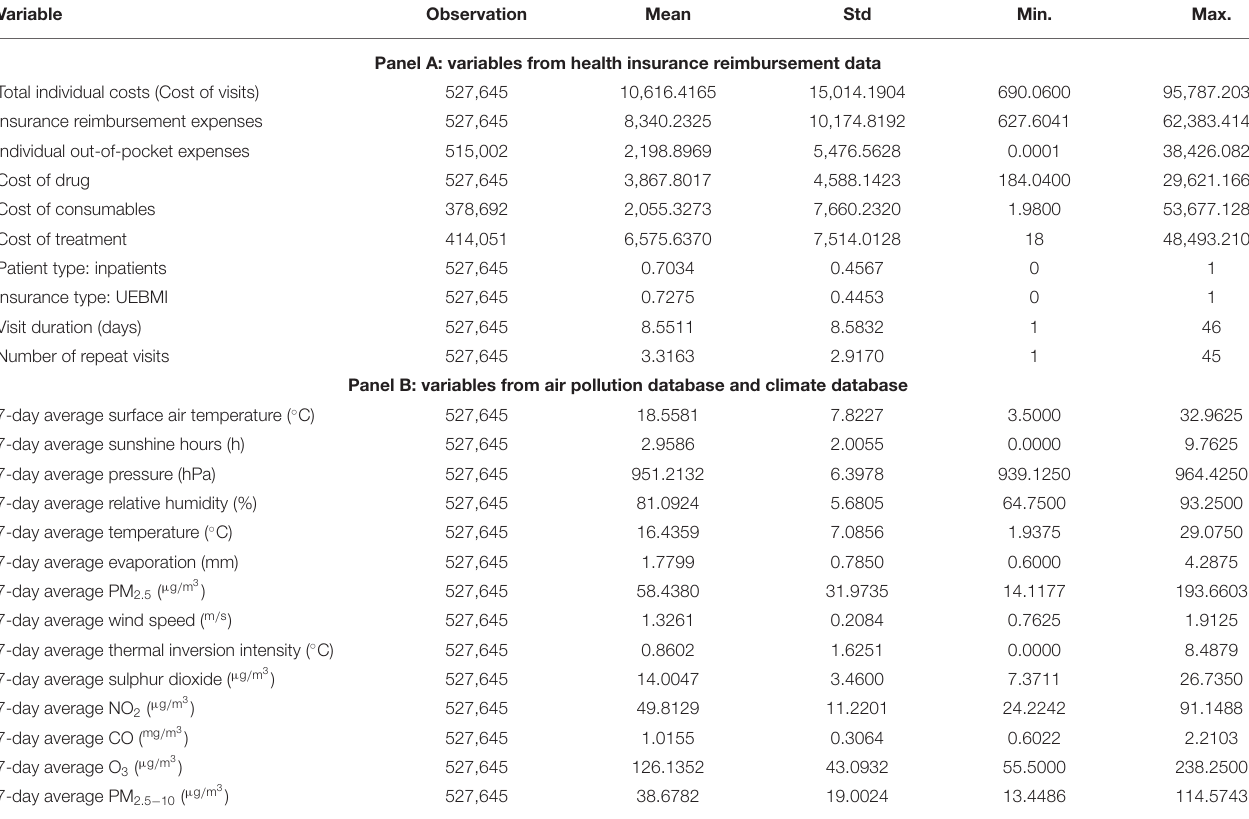
TABLE 2 | Descriptive statistics of variables. Variable Observation Mean Std Min.